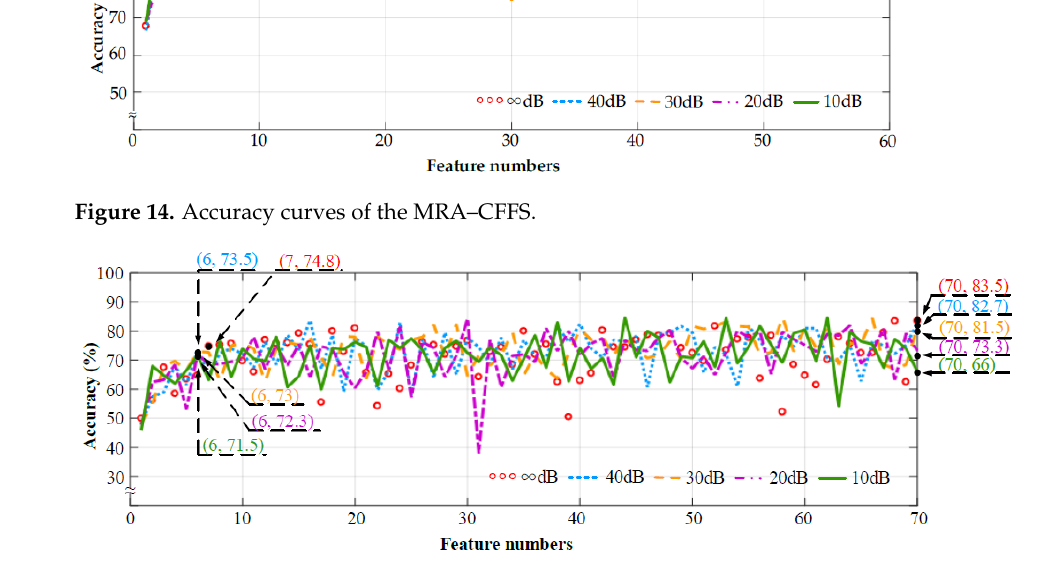
Figure 15. Accuracy curves of the HHT–CFFS.